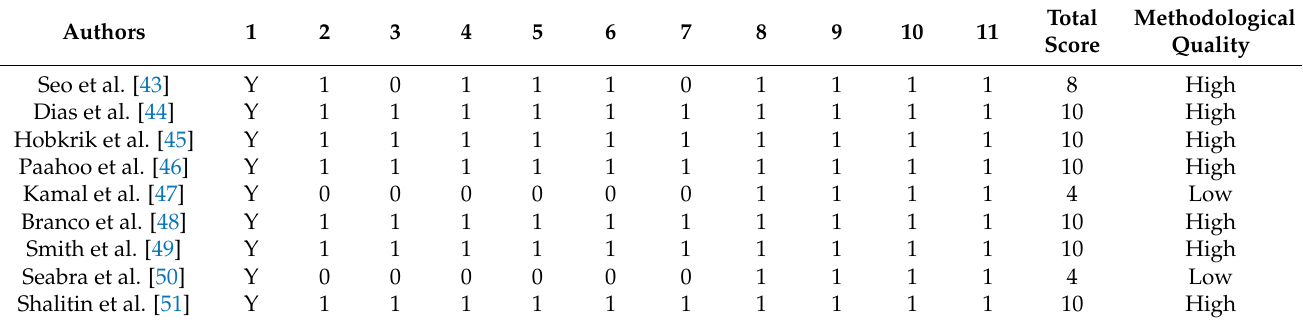
Table 2. Quality assessment of the selected articles (PEDro